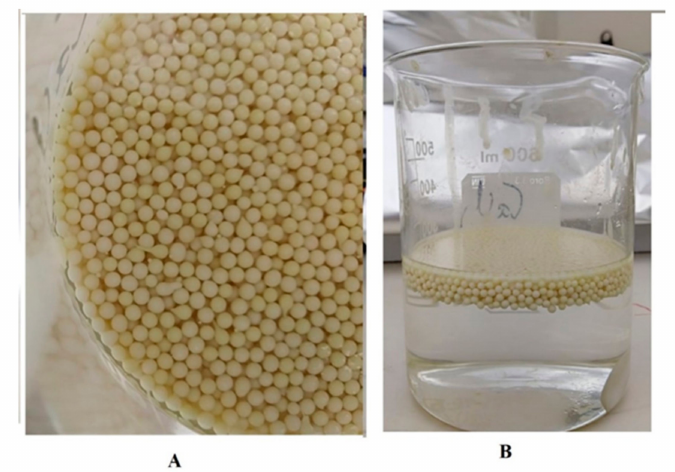
Figure 1. Buoyancy (floating ability) of the prepared EA–Ca pectinate beads. ( A ) Top view and ( B ) side view.